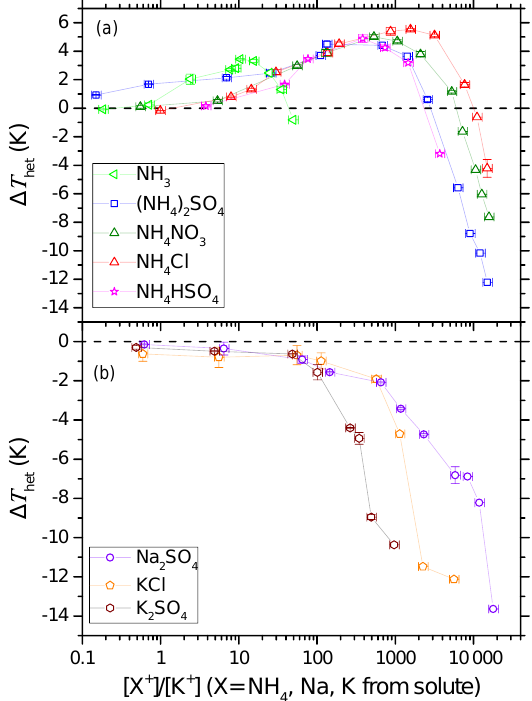
(cid:49)a het w (a w ) ) as a het -containing solutes. (b) Non-NH + 4 4